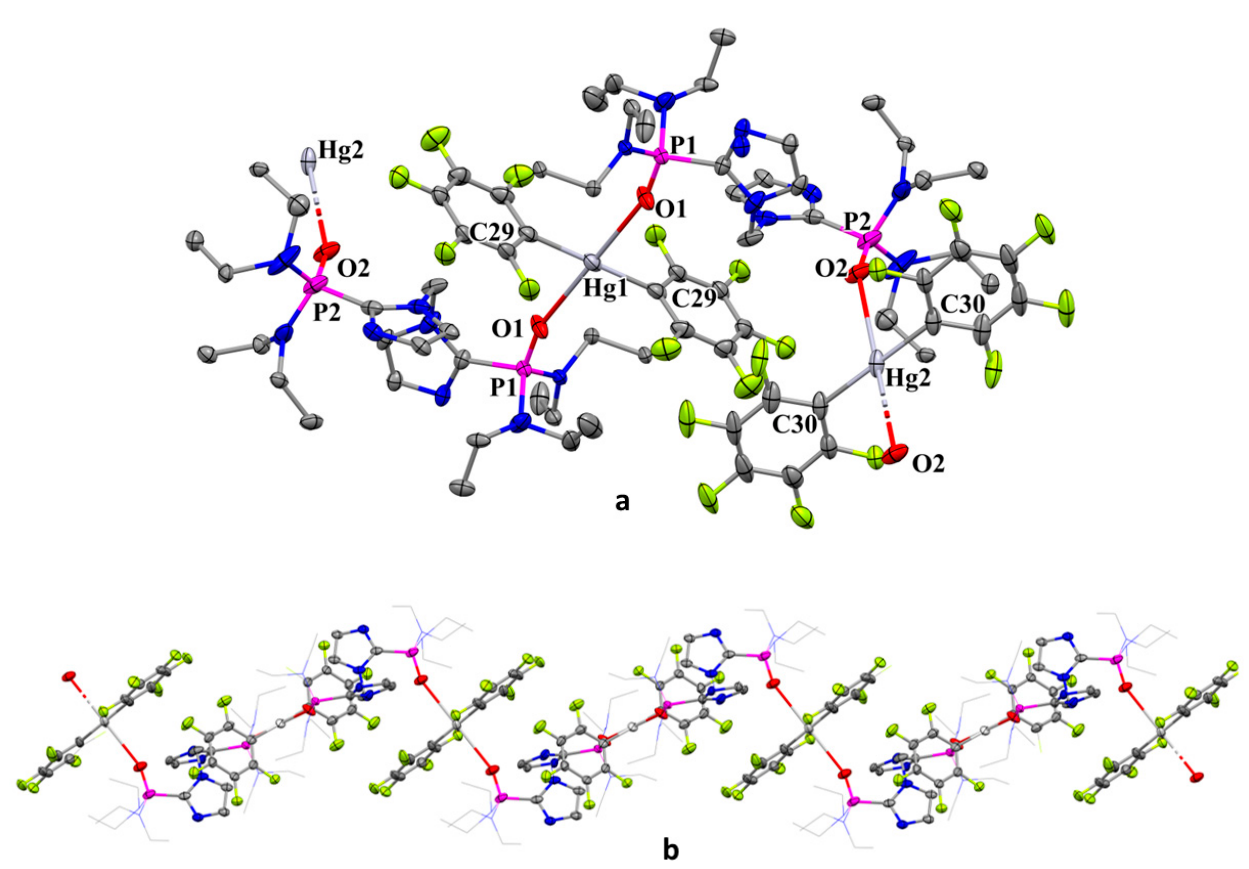
Figure 3. Molecular structure of 2Hg ( a ) asymmetric unit and ( b ) perspective view of 1D polymer. Selected bond lengths (Å) and bond angles (°): Hg1-O1 2.966(3), Hg2-O2 2.979(4), P1-O1 1.475(3), P2-O2 1.479(4), Hg1-C29 2.061(5), Hg2-C30 2.055(5), C29-Hg1-O1 92.77(14), C30-Hg2-O2 82.05(18), C30 ′ -Hg2-O2 97.95(18), C29 ′ -Hg1-C29 180.0, C30 ′ -Hg2-C30 180.0.